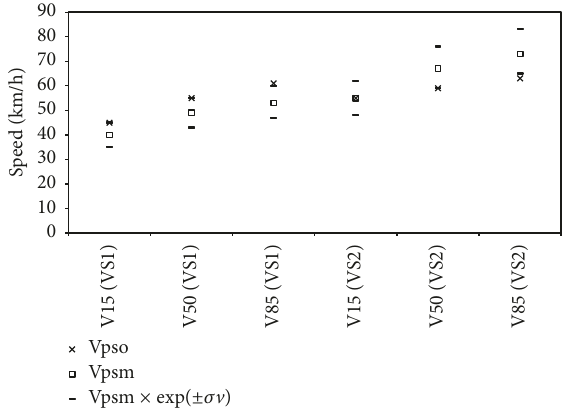
Figure 3: Validation results for conditions of high traffic